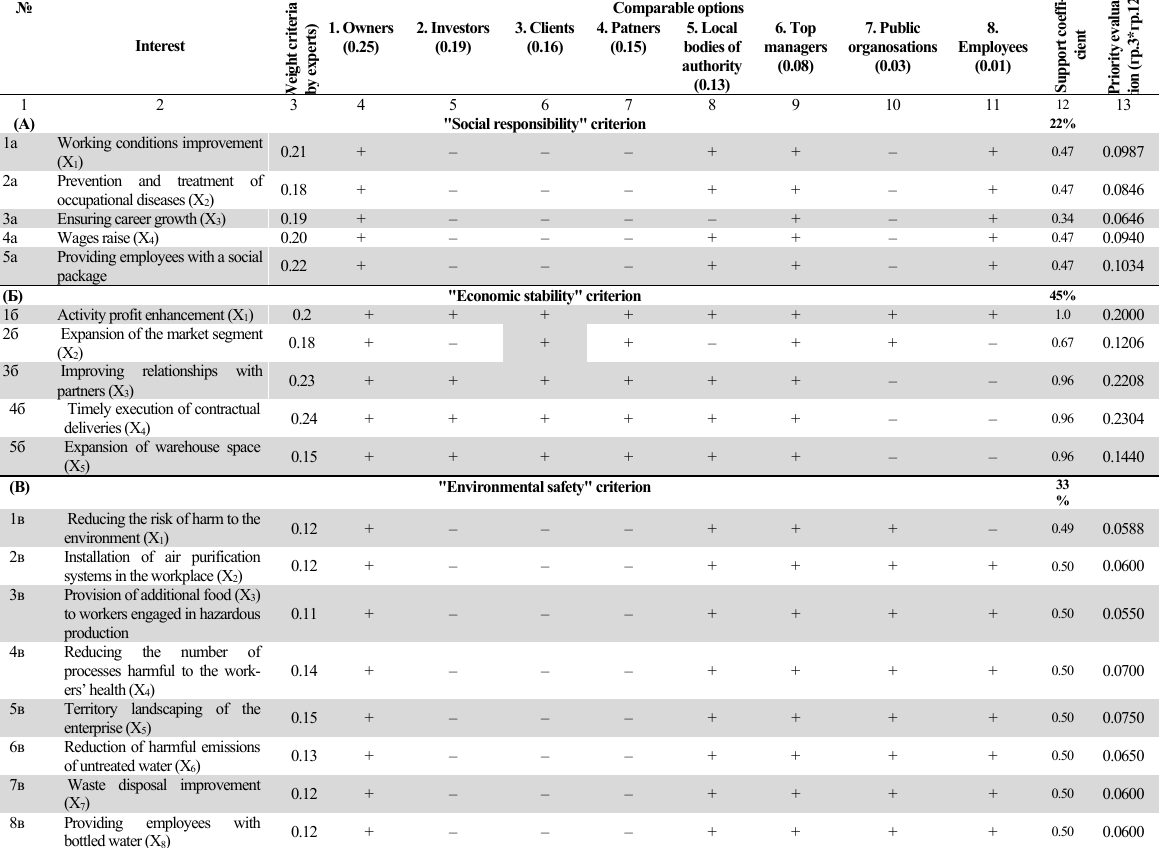
Evaluation of the priority level of stakeholders’interests of the studied enterprise with group significance criteria